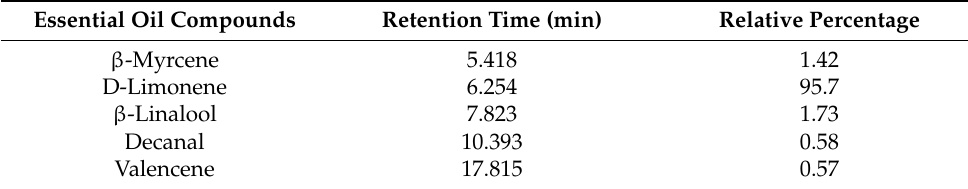
Table 8. Essential oil compounds in C. sinensis peels by